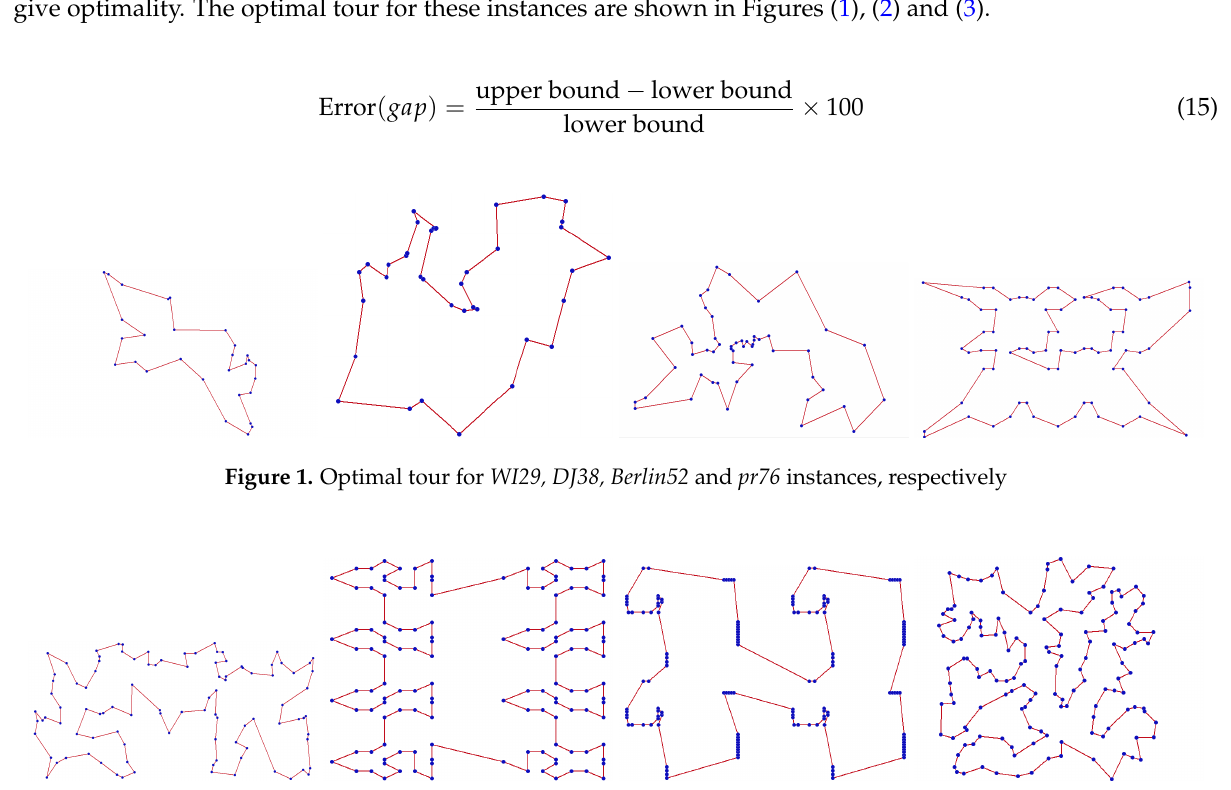
Figure 2. Optimal tour for KrA100, pr136, pr144 and ch150